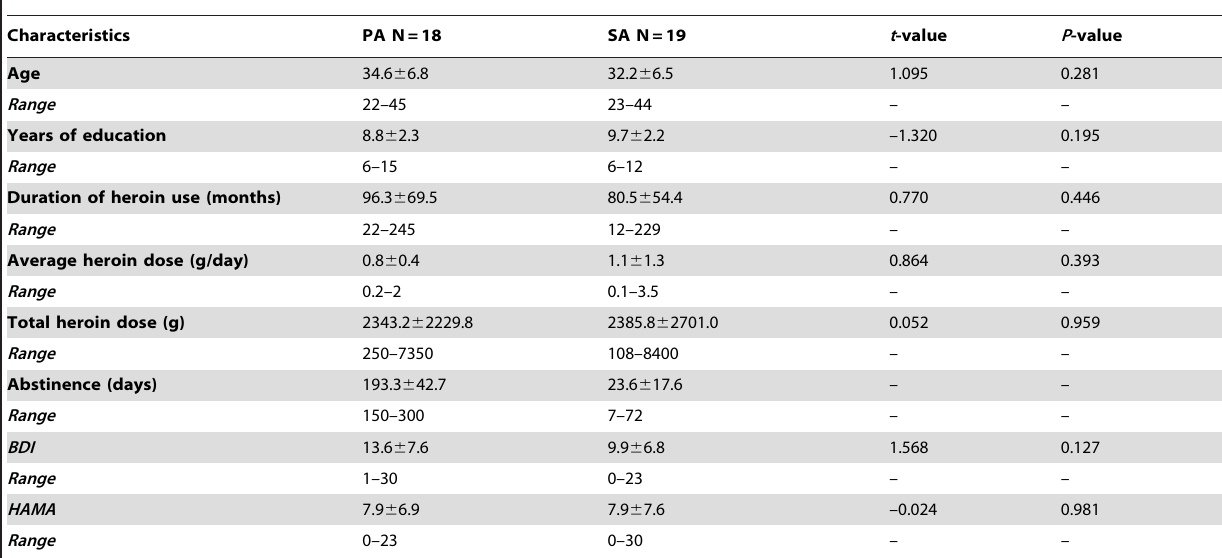
Table 1. Demographic and clinical characteristics of the